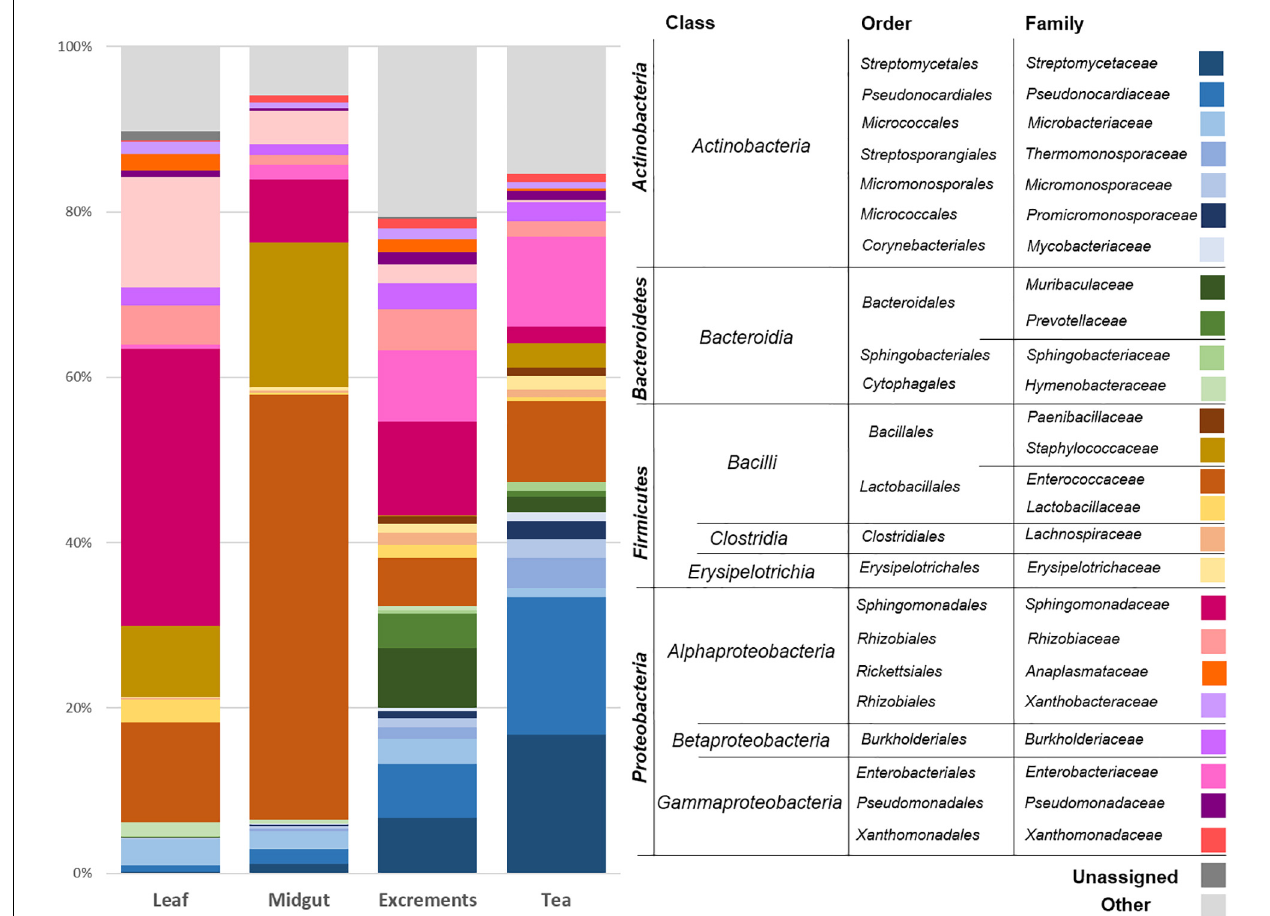
FIGURE 2 | Bacterial community structure of the different sample types. The bacterial community structure was visualized up to family level for each sample type. Taxonomic assignments at higher levels are provided and clustered in the legend. The average abundance of each taxon in six replicates for each sample type (leaf: C. paliurus leaves, midgut: P. farinalis midguts, excrements: P. farinalis excrements, tea: commercial insect tea product) is shown. All taxa with an occurrence of ≥ 1% were included in the legend. Taxa with a lower abundance were summarized as